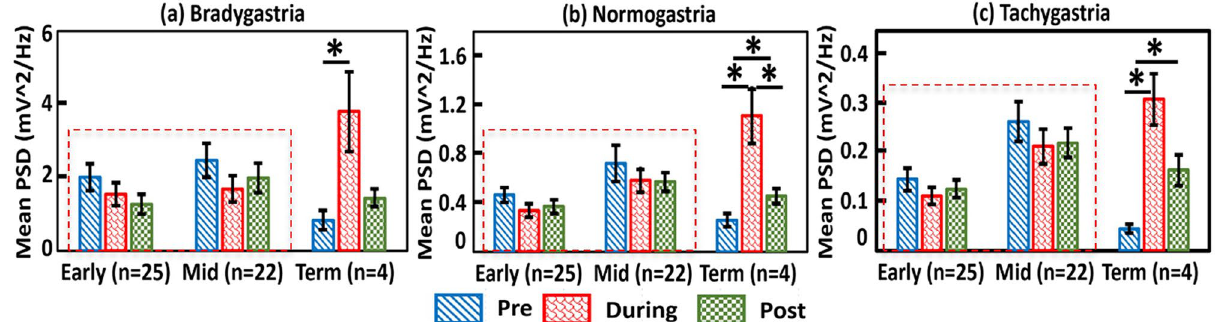
Figure 4. Enteral feeding did not influence the mean power spectral density (mPSD) in preterm infants. Group-level comparisons within each of the three GA groups of the m PSD values across the three feeding periods in ( a ) bradygastria, ( b ) normogastria, and ( c ) tachygastria, respectively. In each panel, the y-axis denotes the m PSD, and the x-axis represents the neonate GA groups. The red dashed boxes outline no significant difference in m PSD across the three feeding phases in both early GA and mid GA infants at all three GR bands. A significant increase in m PSD is marked by “*” and determined by p < 0.05. Error bars denote the Standard Error of the Mean for the respective m PSD values across three GA groups and in each GR